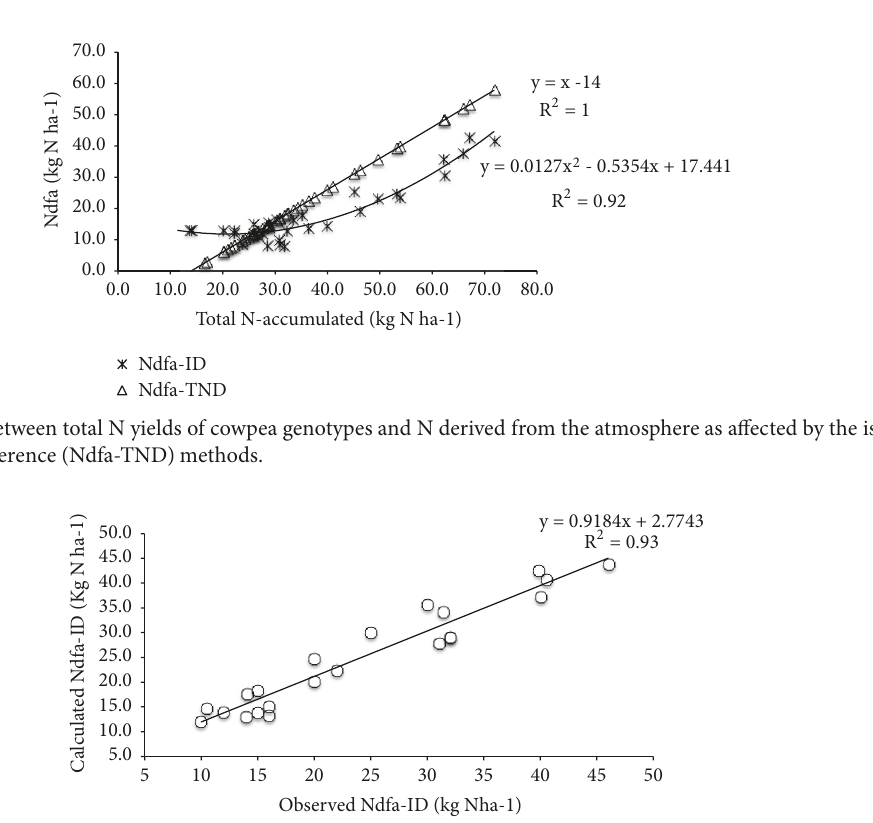
Figure 4: Relationship between theobservedvalues of Nderived fromthe atmosphereby cowpeagenotypes cultivatedwith differentfertilizer treatments (observed Ndfa-ID) and calculated values (calculated Ndfa-ID) from the model equation between total N yields and N derived from the atmosphere with the isotopic dilution method (Ndfa-ID). Number of values: 21; each value represents the mean of 4 values. Data from Bado et al.